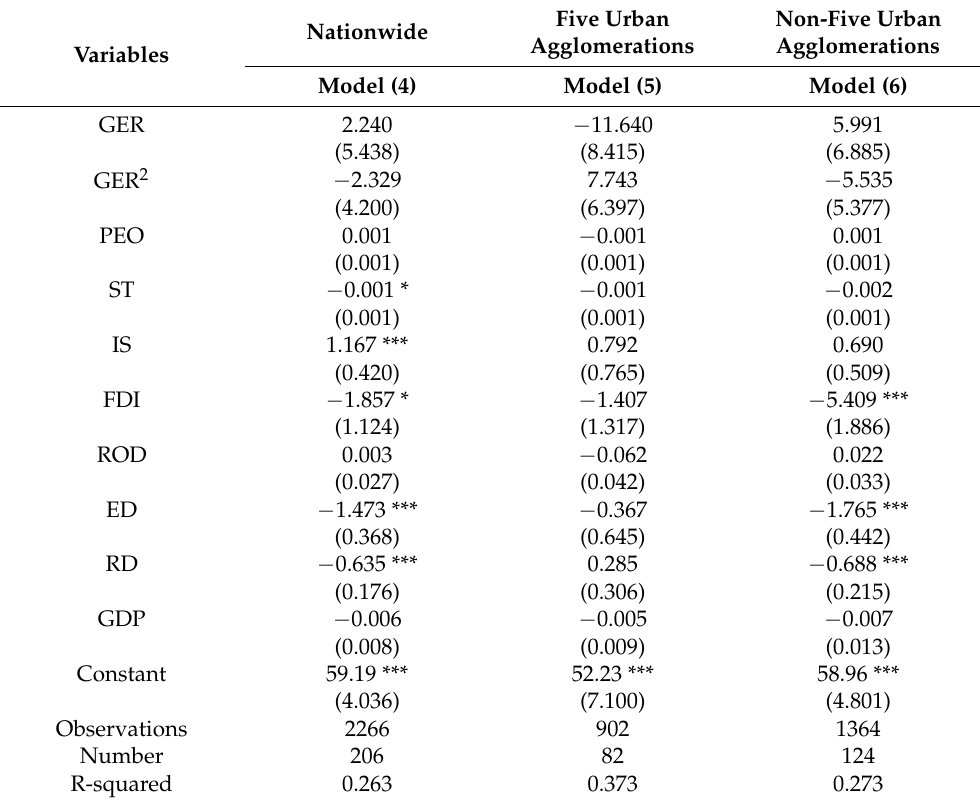
Table 4. Nonlinear models of national, five major urban agglomerations, and non-five major urban